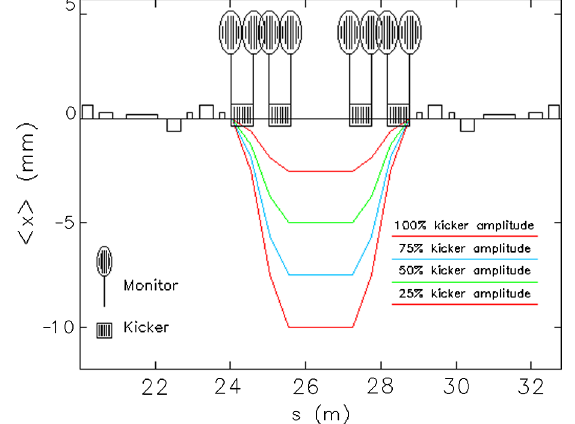
FIG. 21. The horizontal trajectory of the stored electron beam centroid during passing through the kicker magnets. Several monitors have been distributed before and after each injection kicker and after the septum magnet to observe phase space coordinate of the electron beam.